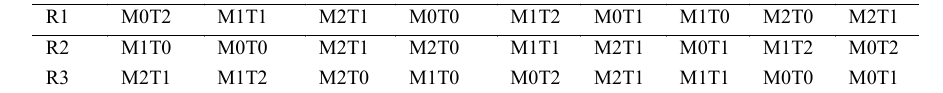
Table 1: Factorial design of treatments